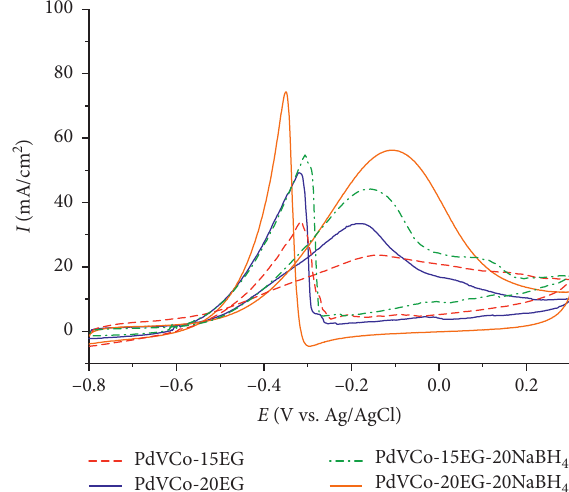
Figure 6: CVs of ethanol electrooxidation on nanocatalysts PdVCo in a solution of 1M KOH+1M C 2 H 5 OH.